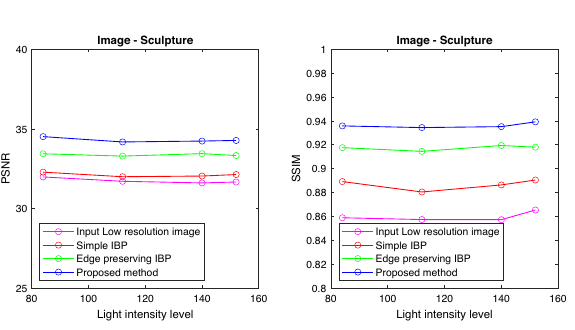
Figure 7. PSNR and SSIM plotted against light intensities—Sculpture